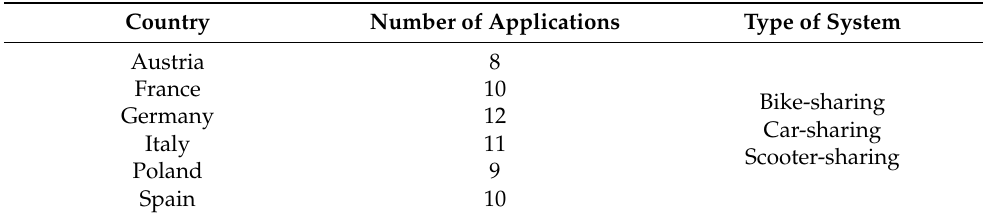
Table 2. Analyzed applications of shared mobility systems.